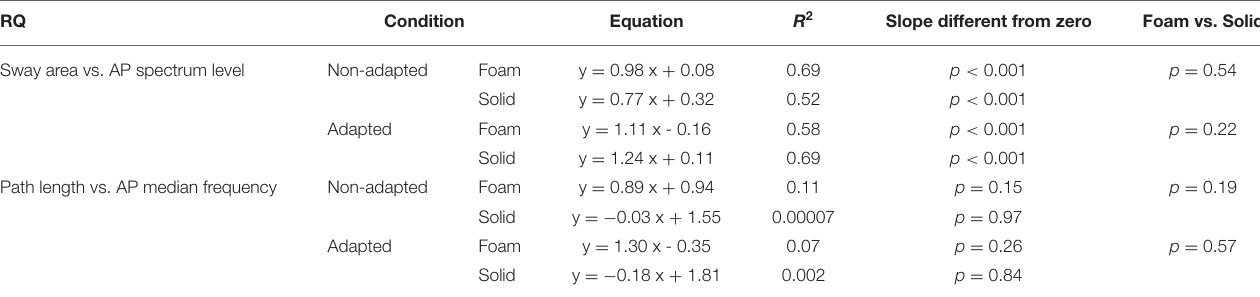
TABLE 7 | Relationship between RQs of Sway Area and AP Spectrum Level and between RQs of Path Length and AP Median Frequency in the non-adapted and adapted trials. RQ Condition R 2 Slope different from zero Foam vs.